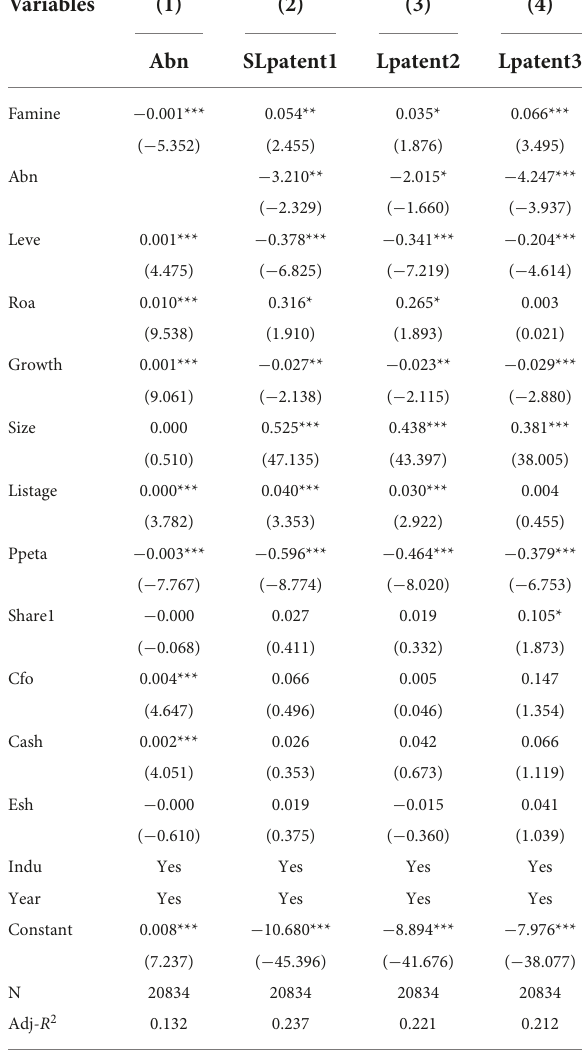
TABLE 7 Test for mediating effects of R&D